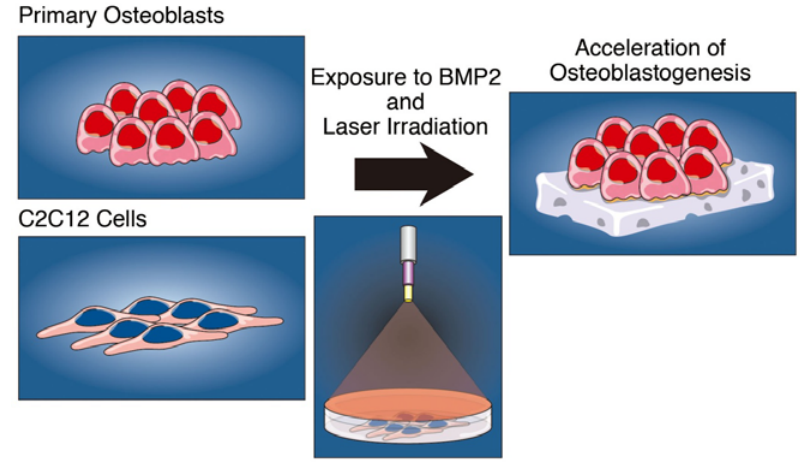
Figure 7. Effects of low intensity laser therapy (LILT) on BMP2-induced osteoblastogenesis. Low intensity irradiation of garnet laser, gallium-aluminum-arsenium (Ga-Al-As) laser accelerated osteoblastogenesis of BMP2-exposed C2C12 cells and primary